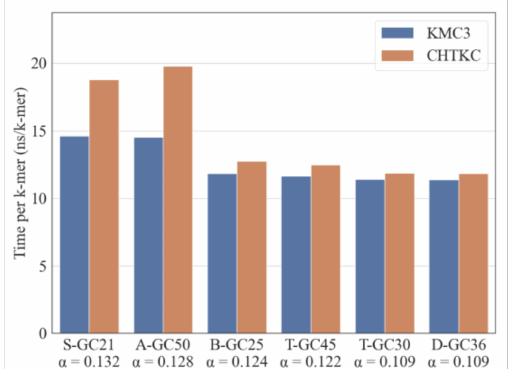
Figure 4. Comparison of KMC3 and CHTKC using various GC-ratio datasets. α is the ratio of the number of distinct 32-mers to total 32-mers.